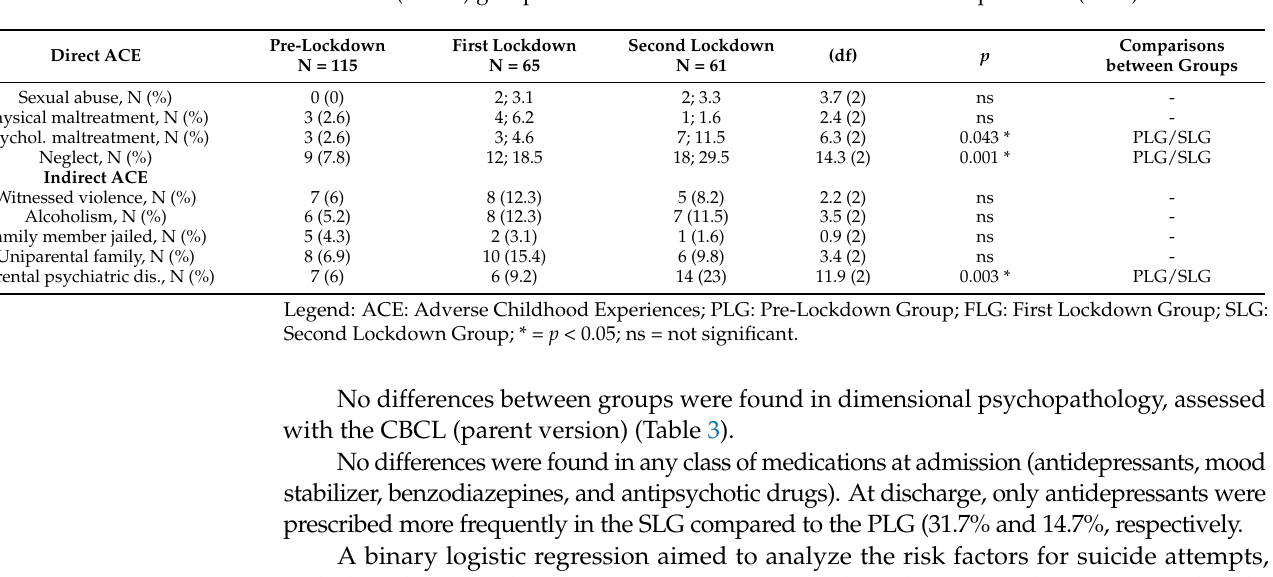
Table 3. Comparison between Pre-Lockdown (n = 115), First Lockdown (n = 65), and Second Lockdown (n = 61) groups: Direct and Indirect Adverse Childhood Experiences